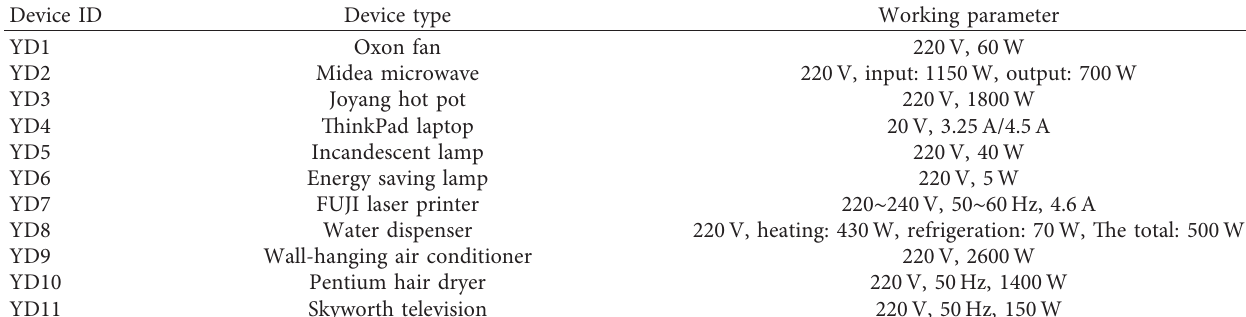
Table 1: Electrical equipment and working parameters.